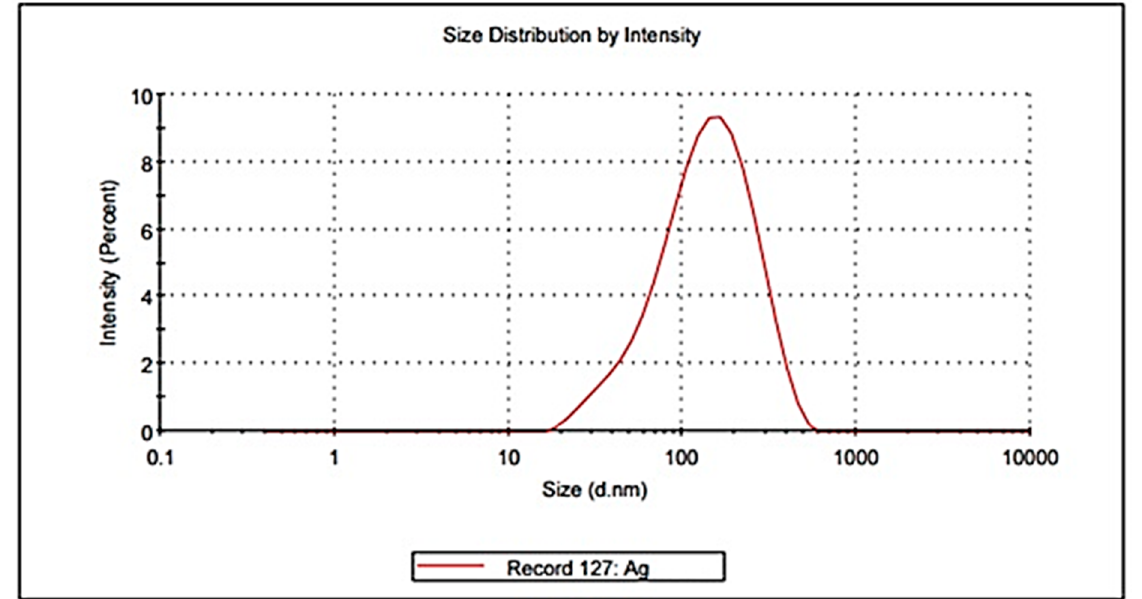
Figure 1. UV-vis absorbance spectra of AgNPs prepared with aqueous A.nilotica pod extract.